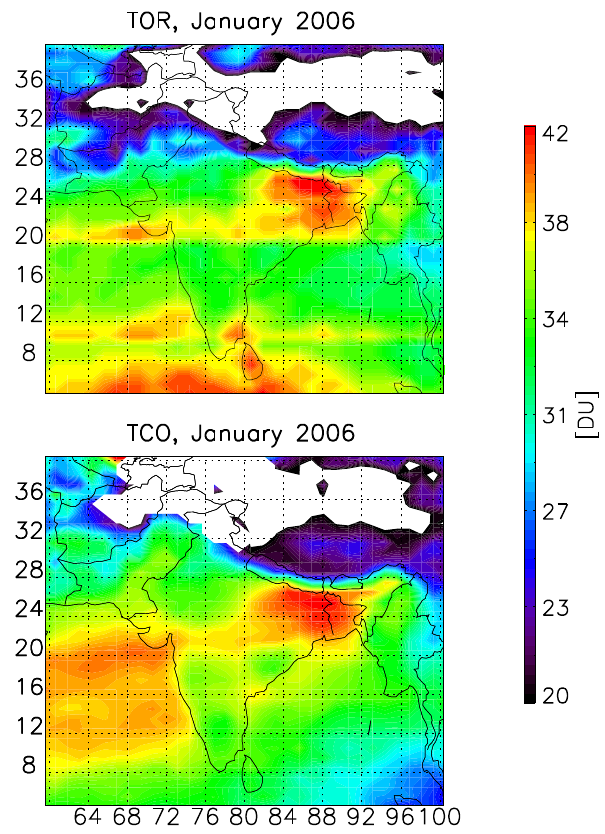
Fig. 12. Distribution of the tropospheric ozone column from TOR (top panel) and TCO (bottom panel) for January 2006.